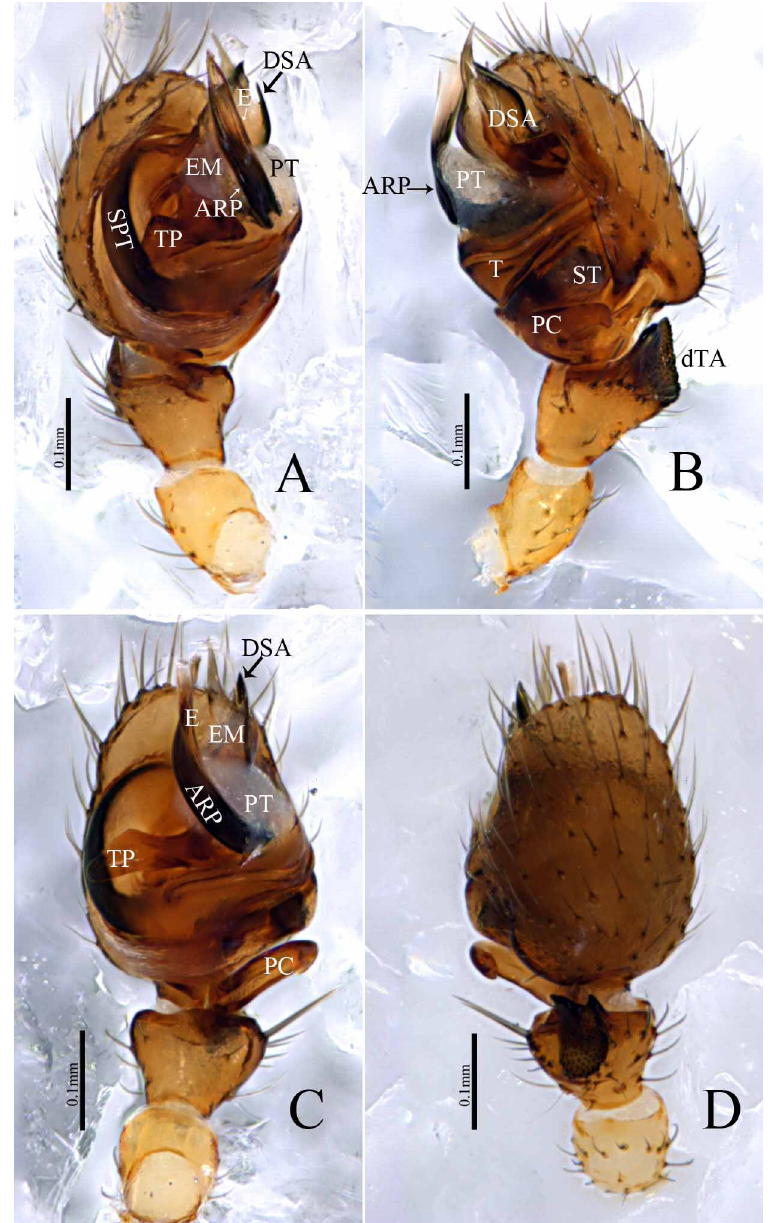
Fig. 1. Yuelushannus alatus sp. nov., male palp, holotype (HNDWS-18-04~01). A . Prolateral view. B . Retrolateral view. C . Ventral view. D . Dorsal view. Scale bars: 0.1